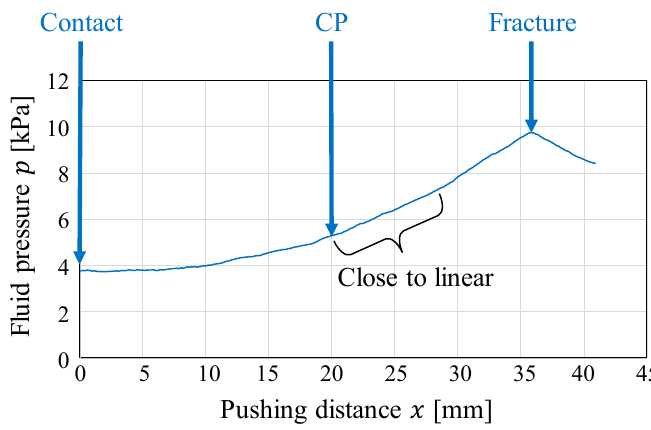
Figure 3. Behavior of the fluid pressure in the compression test.